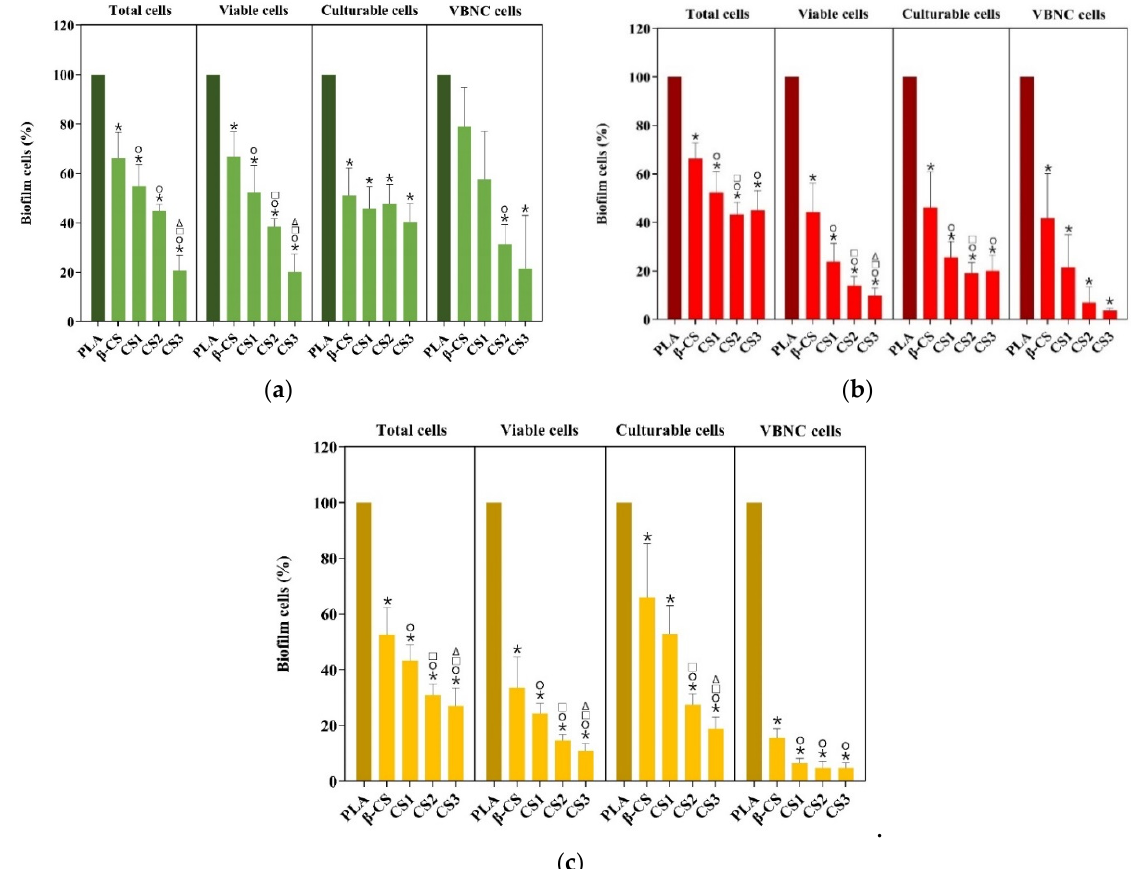
Figure 2. Percentage of total, viable, culturable, and viable but nonculturable (VBNC) cells for ( a ) S. aureus , ( b ) P. aeruginosa, and ( c ) dual-species biofilms formed during 24 h on PLA and CS-coated PLA surfaces ( β -CS, CS1, CS2, and CS3). Differences between functionalized surfaces were evaluated using the nonparametric Mann–Whitney test and represented for p -values < 0.05 by *, ○ , □ , and Δ when compared to PLA, β -CS-PLA, CS1-PLA, and CS2-PLA, respectively.